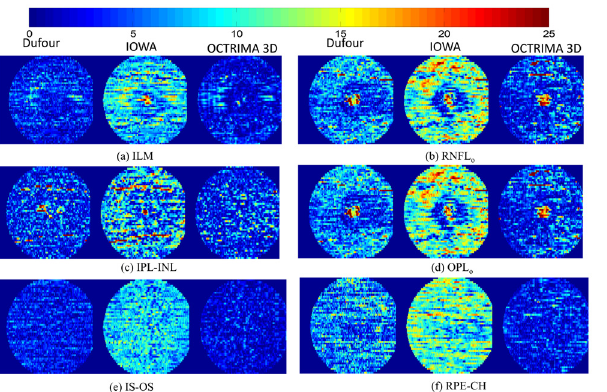
Fig 8. Comparison of unsigned segmentation errors on six surfaces between Dufour ’ s algorithm (left column), the IOWA reference algorithm (middle column) and OCTRIMA 3D (right column) in the ETDRS regions. The graph bar scale indicates the error magnitude in microns. The mean unsigned segmentation errors are reported in Table 2.